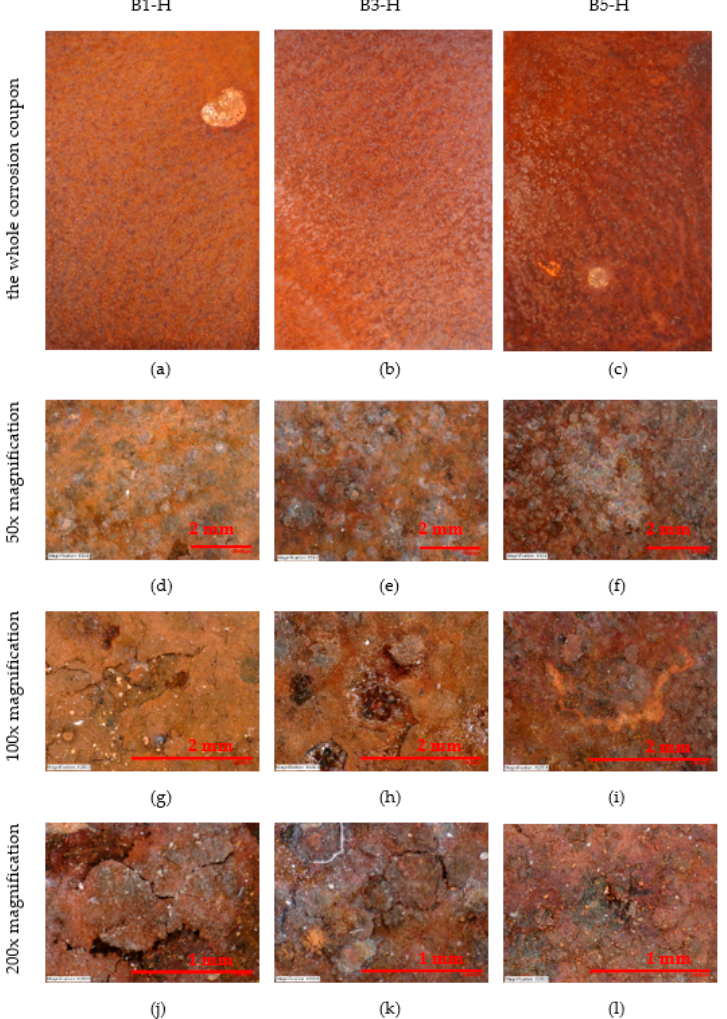
Figure 8. Appearance of horizontal corrosion coupons on stands—50×, 100× and 200× magnifica- tion. ( a – c ) The whole corrosion coupons; ( d – f ) 50× magnification of corrosion coupon surface; ( g – i ) 100× magnification of corrosion coupon surface; ( j – l ) 200× magnification of corrosion coupon sur- face.